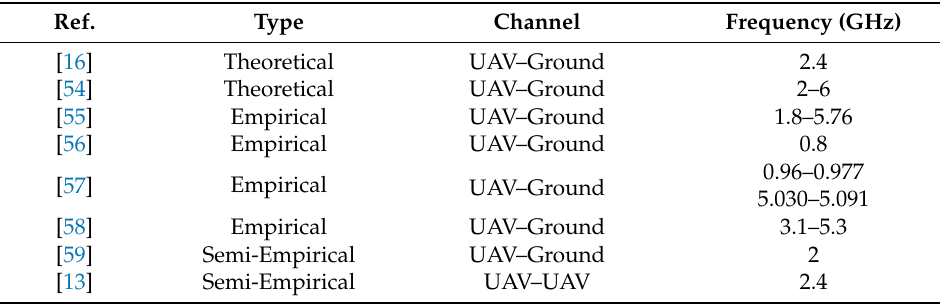
Table 4. Comparative of channel models in